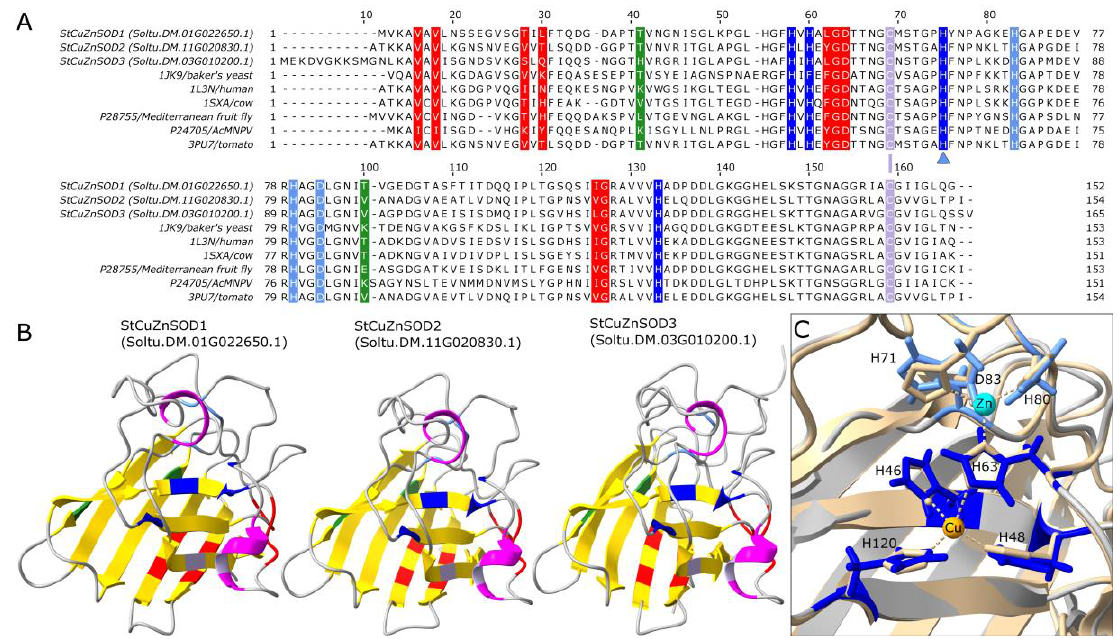
Figure 4. Structural features of StCuZnSODs. ( A ) Multiple sequence alignment of StCuZnSODs with several sequences of the same class with experimentally determined PDB structures. Processed StCuZnSOD sequences are shown based on TargetP2 transit peptide prediction. Residues are anno- tated according to CDD accession cd00305 (Cu/Zn_Superoxide_Dismutase): E-class dimer interface (eukaryotic polypeptide binding site) residues are colored red; P-class dimer interface (prokaryotic polypeptide binding site) residues are colored green; residues involved in Cu ion binding are col- ored blue, and residues involved in Zn ion binding are colored light blue. The arrow indicates the residue which is involved in binding of both Cu and Zn ions. Two cysteine residues involved in a disulfide bond as well as a bond itself (line) are colored violet. ( B ) AlphaFold models of StCuZnSODs: β -strands are colored yellow, α -helices are colored magenta, specific residues are colored as in A. ( C ) Metal binding site of StCuZnSOD2: the AlphaFold model of StCuZnSOD2 (in grey) was 3D aligned with 3PU7 (in tan) PDB structure (experimentally determined PDB structure of the tomato CuZnSOD). Metal ion position and coordinate bonds are based on 3PU7 Biological Assembly 1. StCuZnSOD2 residues involved in Cu and Zn ion binding are colored blue and light blue, respec- tively, and labeled according to processed peptide position. H63 residue is involved in binding of both metal